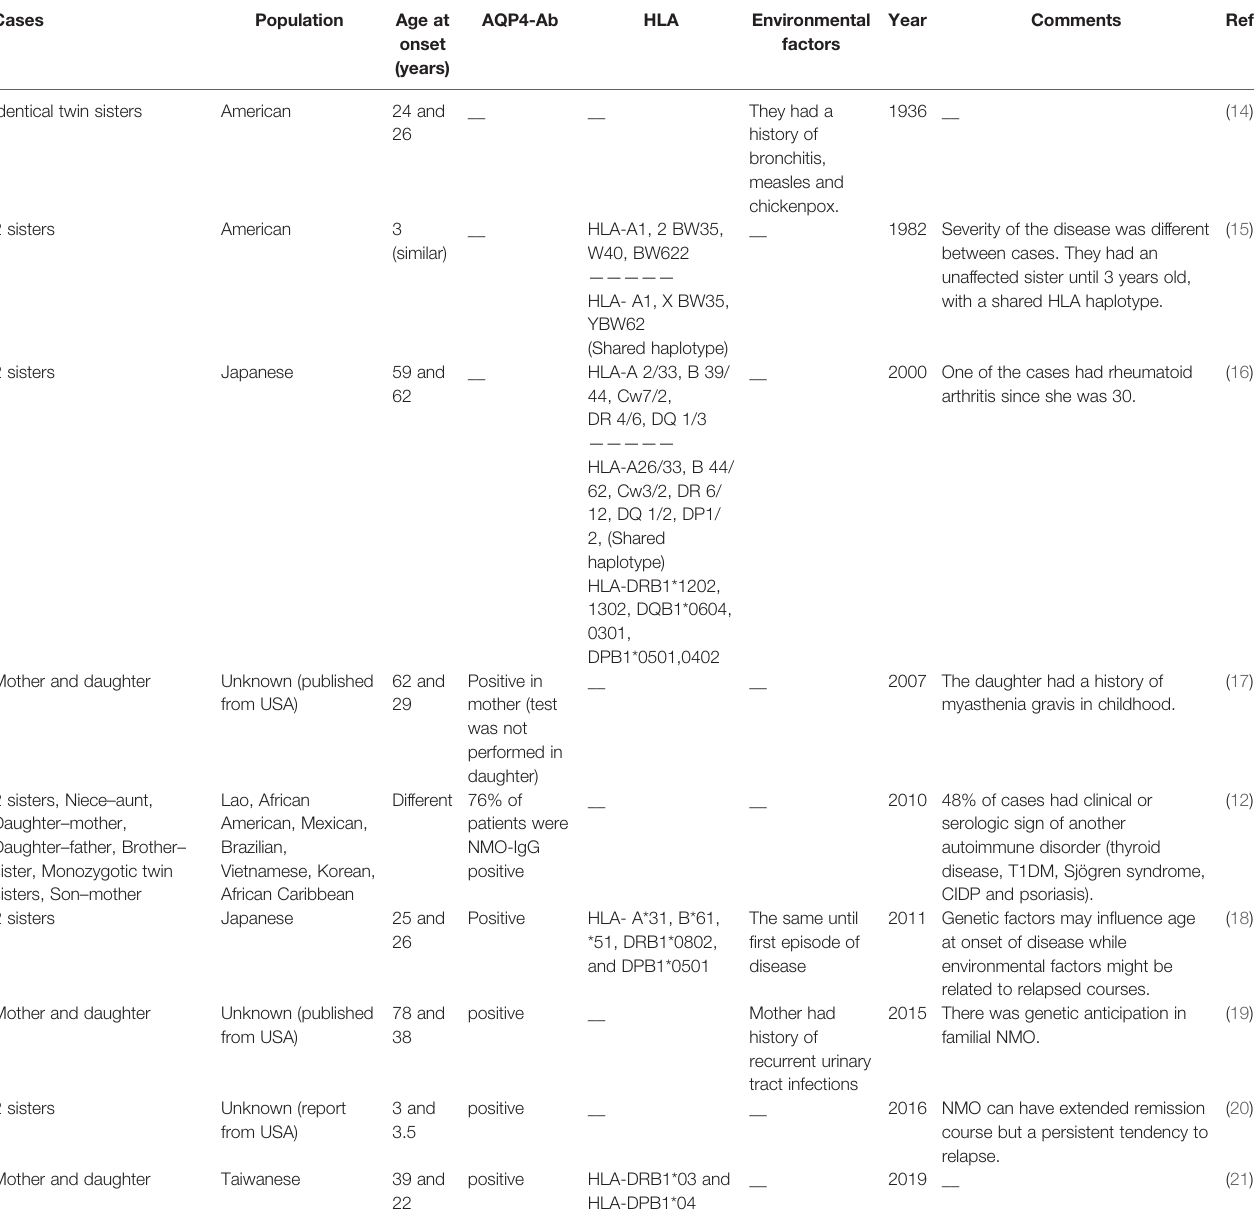
TABLE 1 | Summary of the results of family studies in neuromyelitis optica [HLA, human leukocyte antigen, AQP4-Ab, aquaporin-4 antibody (NMO-IgG)].